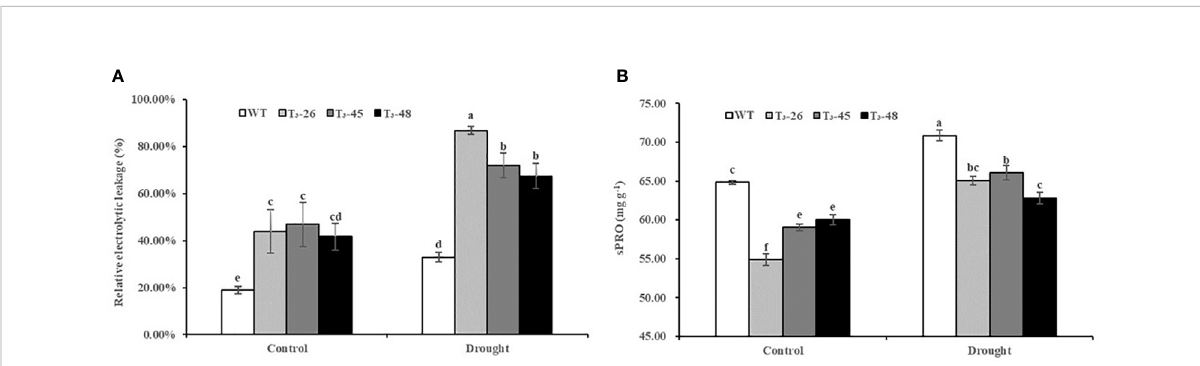
FIGURE 8 NtCPS2 functions in membrane permeability. (A) Comparisons of relative electrolyte leakage rates in the transgenic lines and WT. (B) The content of soluble protein (sPRO) in the transgenic lines and WT. Error bars represent means ± SD. Statistical analysis was performed using the ANOVA test (p< 0.05) and signi fi cant differences are indicated by different letters.